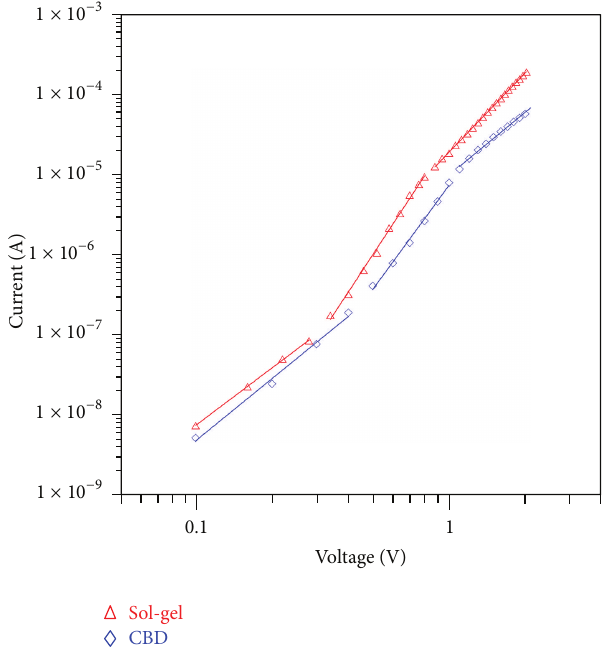
Figure 5: The forward bias log (𝐼) versus log (𝑉) plots of the Au/CuO/p-Si/Al diodes from the data in Figure